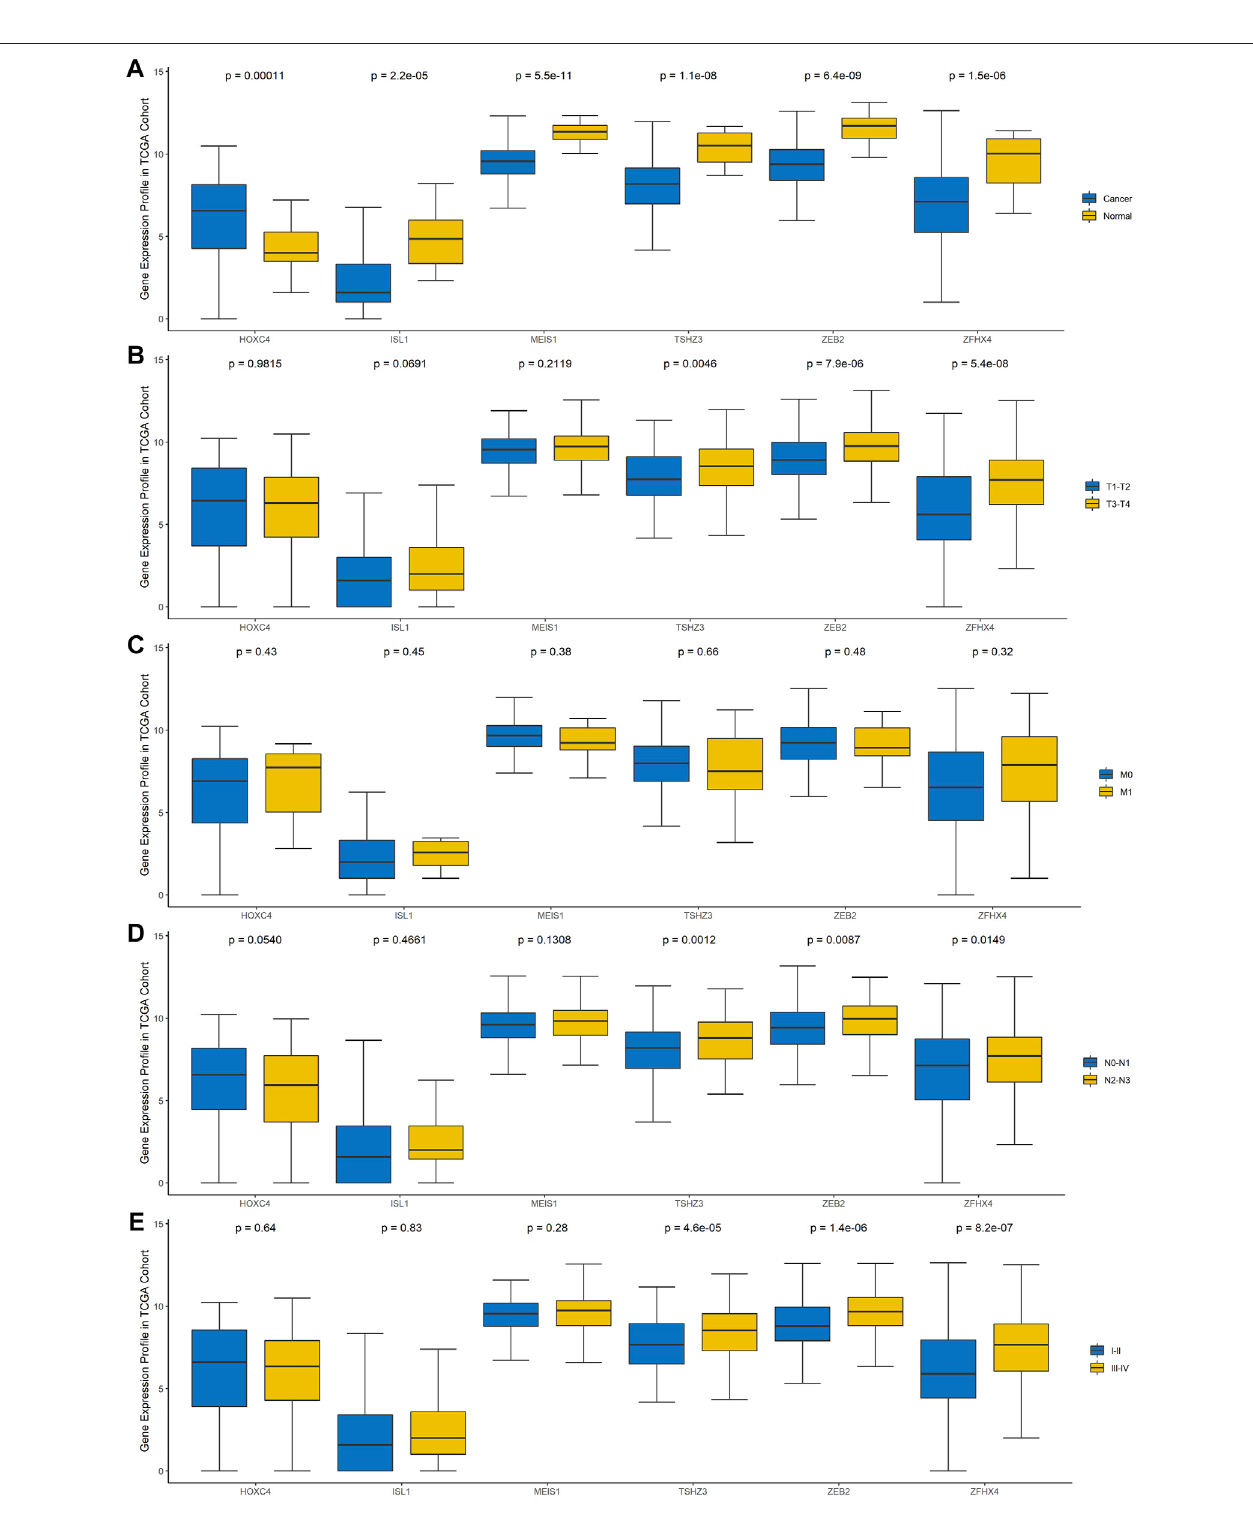
FIGURE 3 | Gene expression pro fi le of these six genes in TCGA cohort. (A) Differences in the expression of the six genes between BLCA tissues and normal tissues. (B) DifferencesintheexpressionofthesixgenesindifferentTstages. (C) DifferencesintheexpressionofthesixgenesindifferentNstages. (D) Differencesinthe expression of the six genes in different M stages. (E) Differences in the expression of the six genes in different clinical stages.